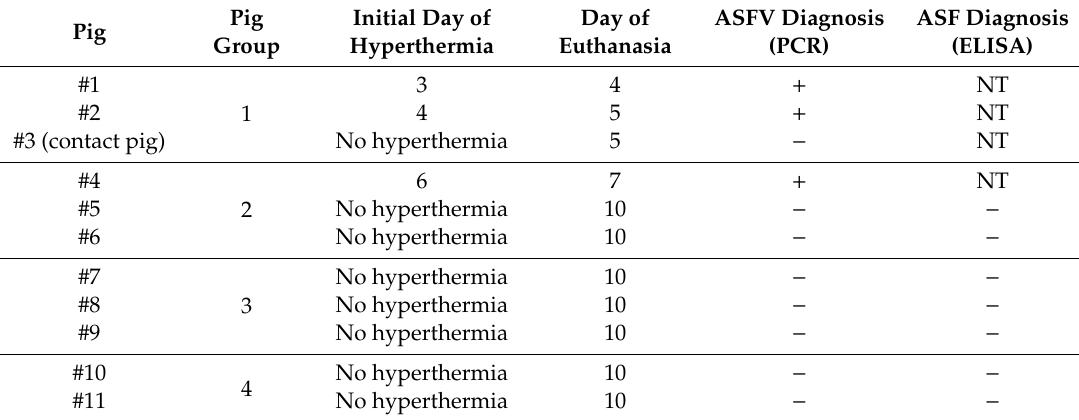
Table 1. Pig infection by ingestion of infected ticks at zero and two months post-infection or “virus spiked brioche ”.